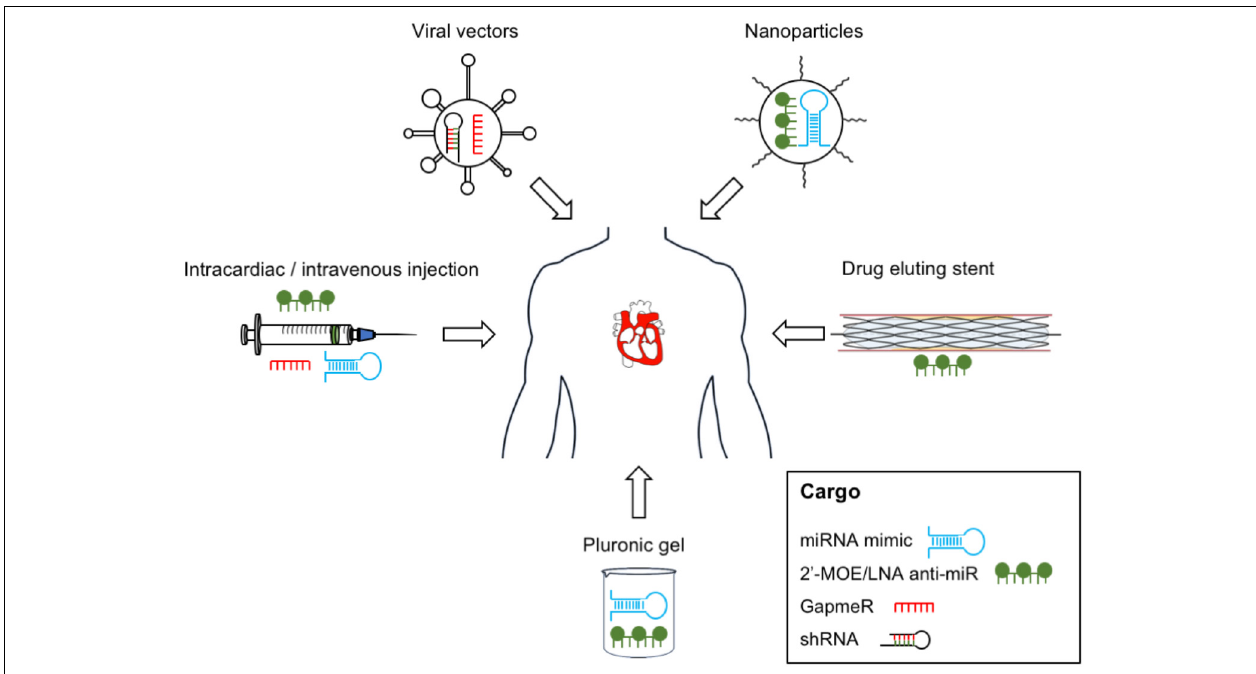
FIGURE 2 | Non-coding RNA therapy delivery – proposed delivery methods of ncRNA-based therapeutics in vascular disease. RNA therapeutics can be delivered to the vascular system using vehicles such as viral vectors, nanoparticles, and pluronic gel; intravascular devices such as drug-eluting stents; or by direct injection.